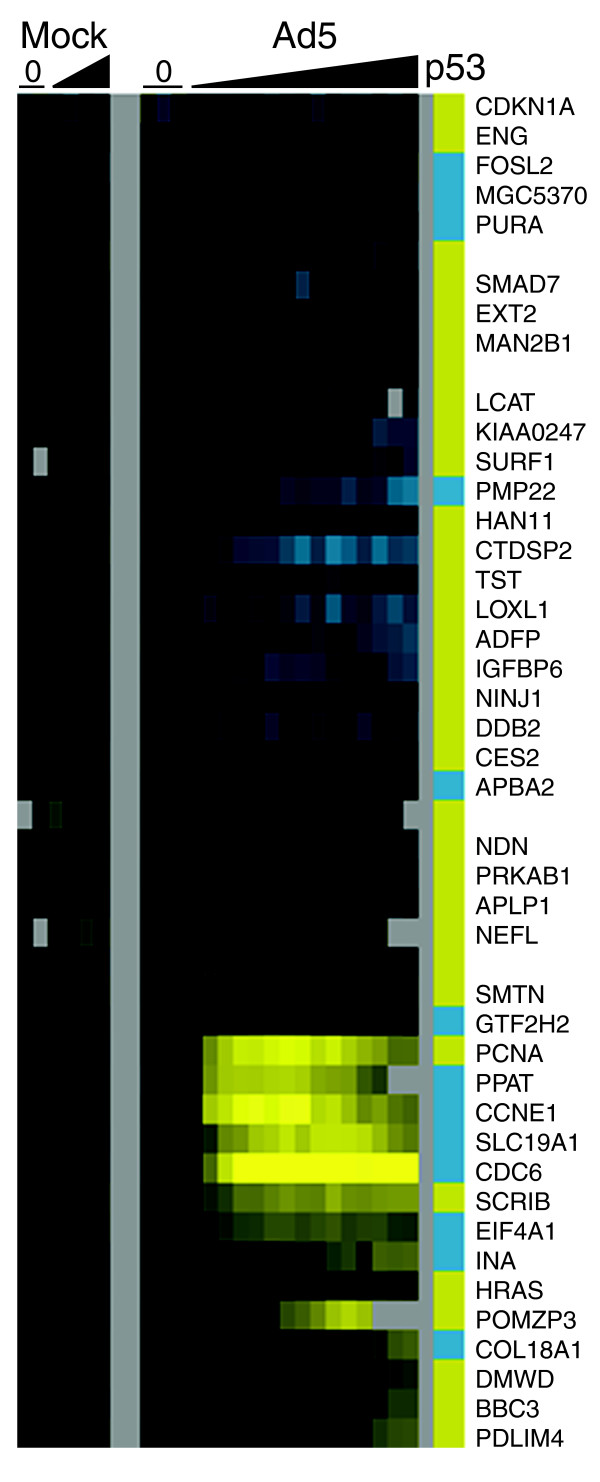
Changes in expression of direct p53 target genes induced by Ad5 infection. The 50 or so genes that are direct p53 targets in human lung fibroblasts [94] are shown clustered based on the changes in their expression observed in adenovirus type 5 (Ad5) infected human foreskin fibroblasts. The column labeled p53 summarizes the p53 induced alterations in expression of these genes, which are listed at the right. Ramps above panels indicate increases in time after infection.